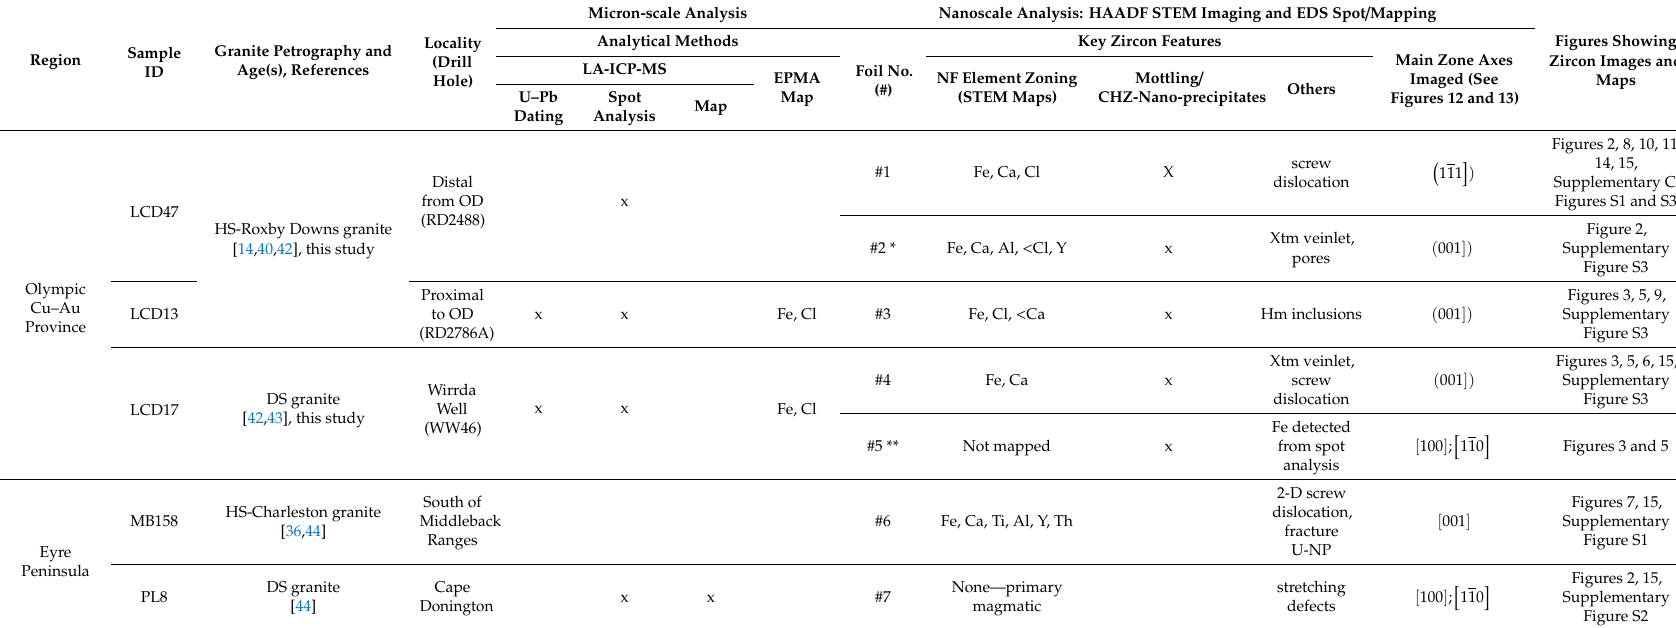
Table 1. Summary of the samples and foils investigated in this